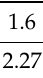
Figure 15. H · ∇H value of N-N arrangement ( a ) and N-S arrangement ( b ) ( 𝐵 (cid:3045) = 1.2 T). 4